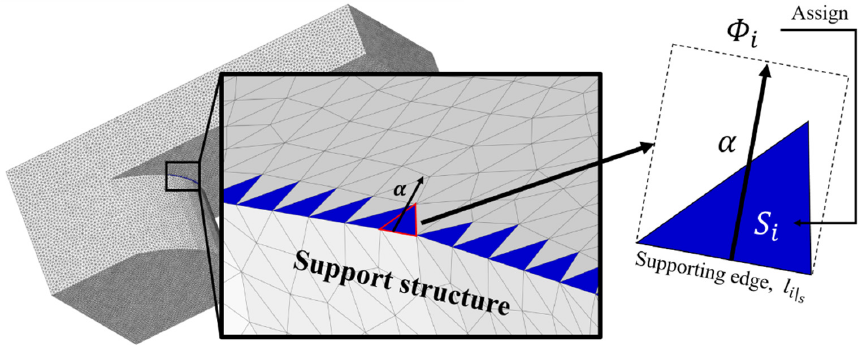
Figure 8. Initial step of collapse region search algorithm proposed herein.